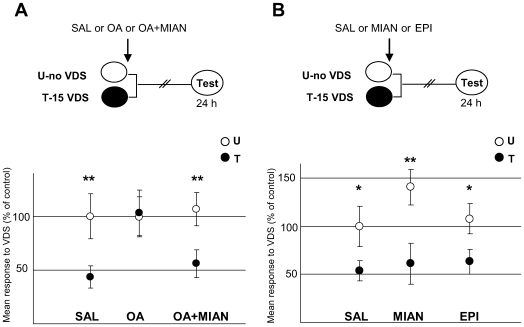
Effect of OA antagonists over aversive memory.A) Mianserin reverts the amnesic effect of OA when coinjected. (Upper diagram): Experimental protocol. Three U–T pairs: SAL (N = 30 per group), 1 mM OA (N = 31 per group) and a cocktail of 1 mM OA+MIAN (N = 34 per group), applied 0 h after training (arrow). Symbols as in Fig. 2. (Lower panels): Results of Testing session for the three pairs. Ordinates and symbols as Fig. 2. B) OA antagonists do not impair aversive memory in a 1 mM dose. (Upper diagram): Experimental protocol. Symbols as in Fig. 2. Three U–T pairs: SAL (N = 30 per group), 1 mM MIAN (N = 30 per group) and 1 mM EPI (N = 38 per group) applied 0 h after training (arrow). (Lower panel): Results of the Testing session for the three pairs. Ordinates and symbols as in Fig. 2.